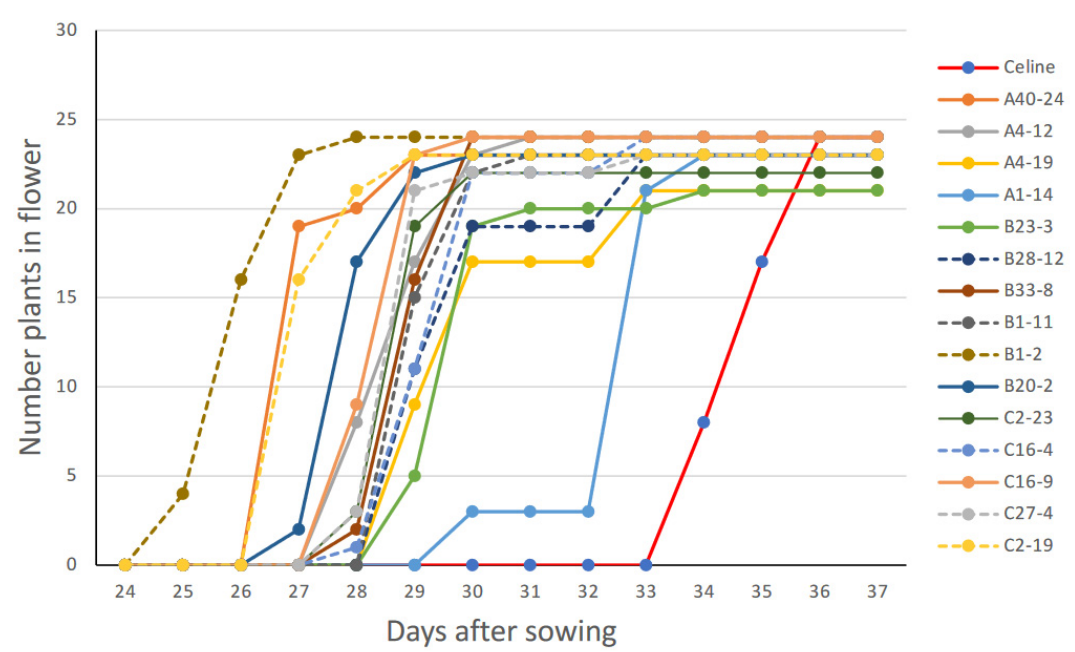
Figure 3. Time to flowering in the T5 families. Plants were grown in 24-pot multipots. A date tag was attached to each plant on the day when the first flower opened. The date of flowering was noted for each plant when they were harvested. Table 1. Summary of phenotypes of the T5 family. T5